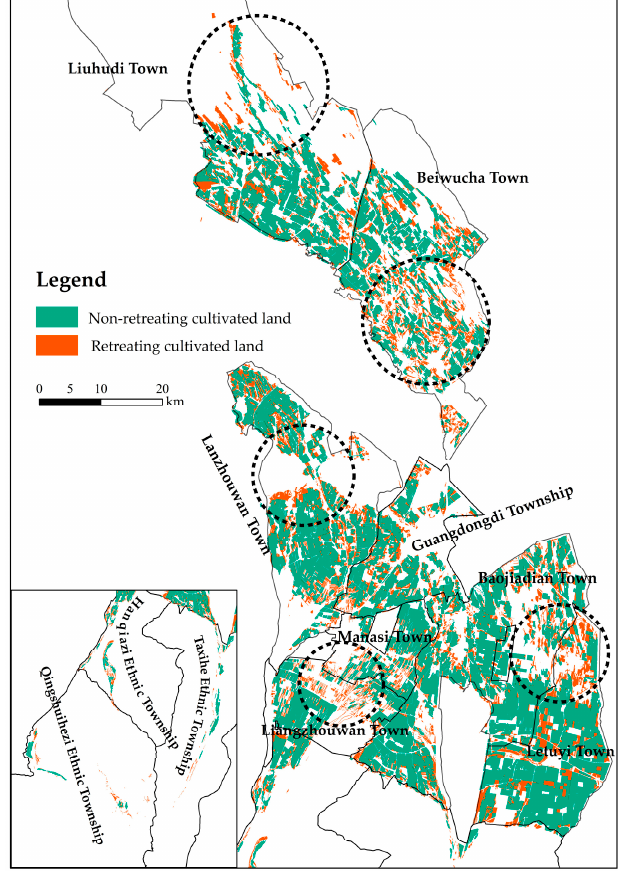
Figure 5. Spatial distribution of cultivated land in Manas County.